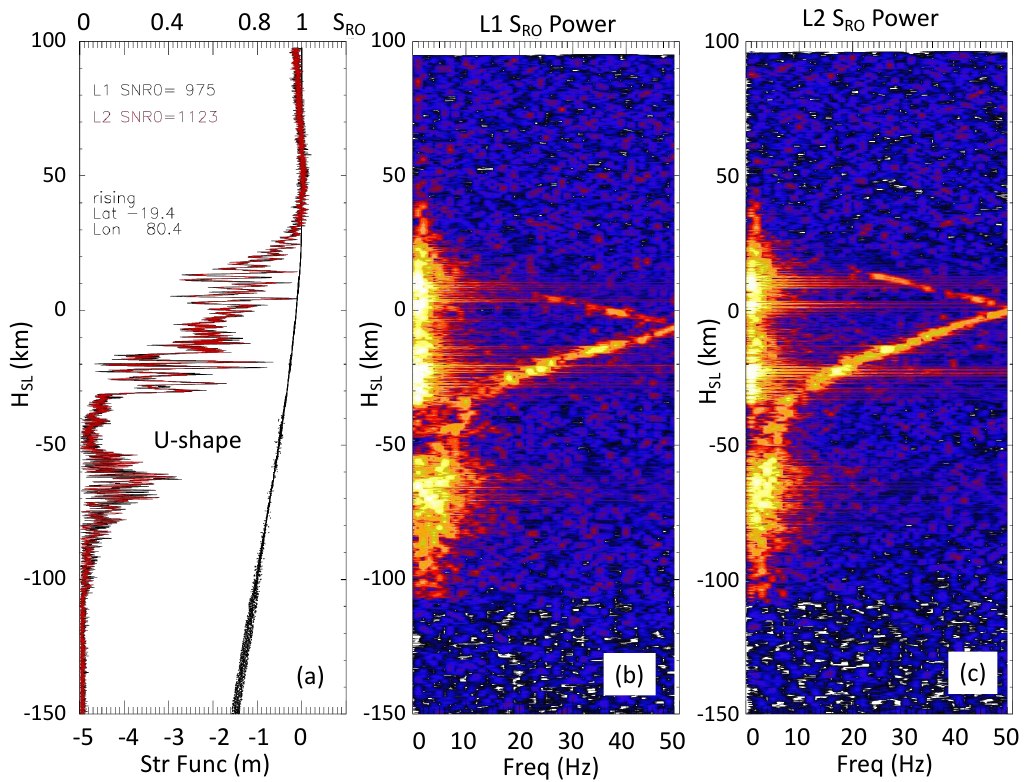
Figure A5. ( a ) An example of COSMIC-2 rising occultation at (19.4° S, 80.4° E) with S RO profiles from L1 and L2 channels and structure function of f exL1 ; and ( b , c ) L1 and L2 S RO power spectrum profiles, respectively, with the spectral power colored in a logarithmic scale. The free-space SNR 0 of L1 and L2 signals are 975 and 1123 V/V, respectively. The structure function is defined as the difference of f exL1 measurements between adjacent H SL .